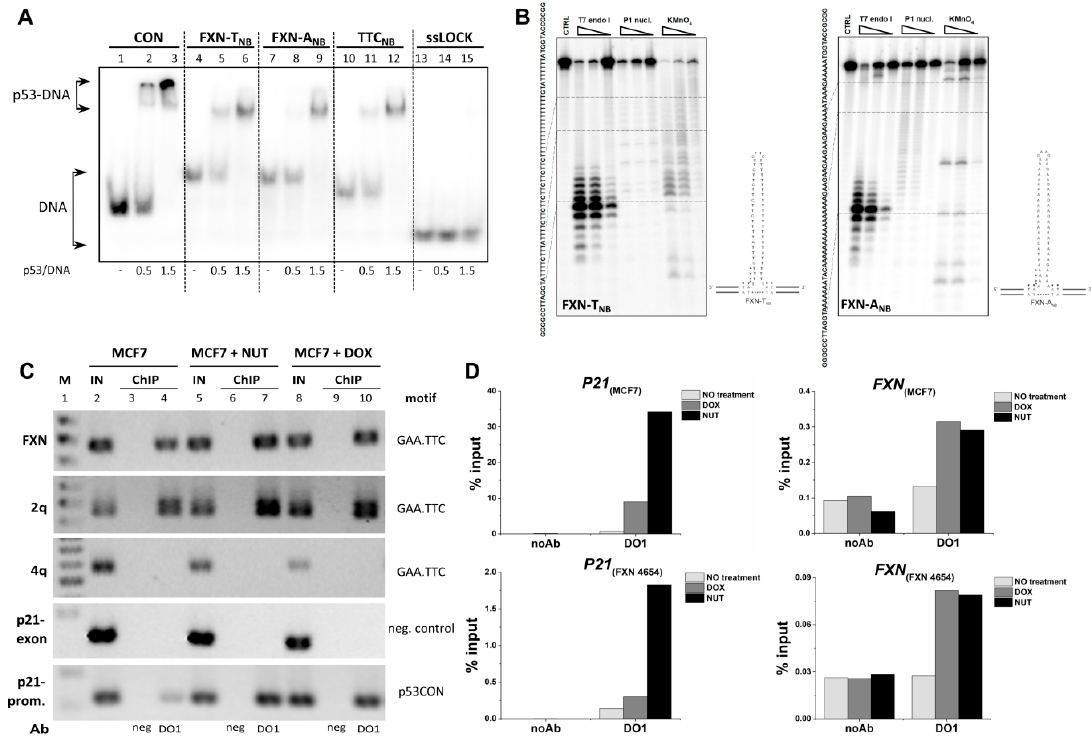
Figure 4. Full length p53 binding to GAA·TTC trinucleotide repeat within the sequence context